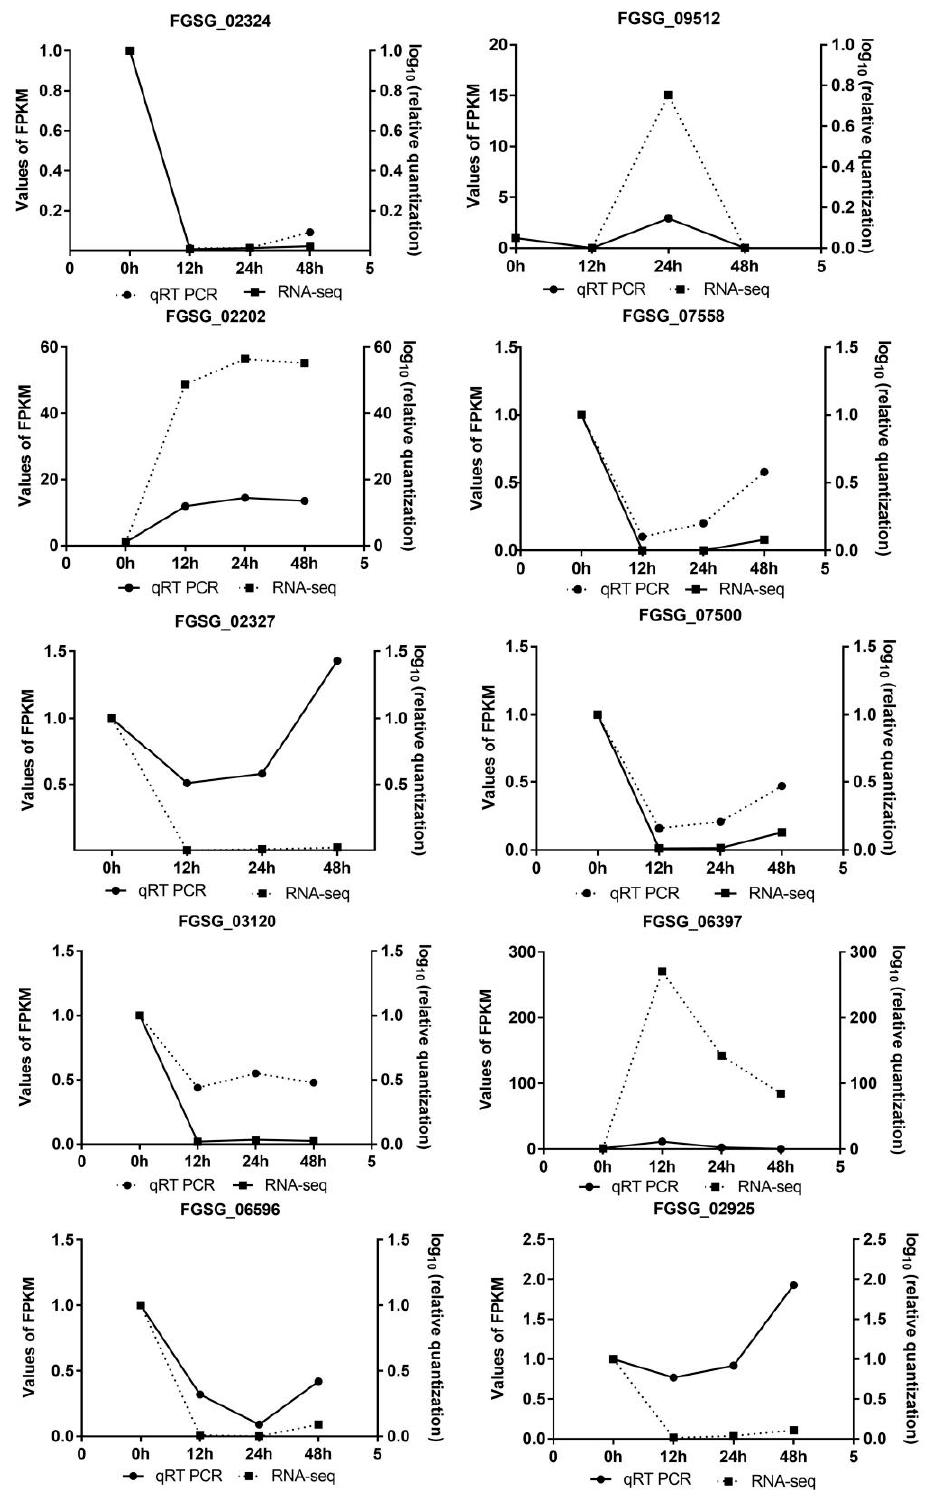
Figure 5. Expression change of 10 randomly selected genes of F. graminearum from RNA-seq. The expression pattern and level of selected genes from RNA-seq results were compared with those quantified by qRT-PCR. Quantitative analysis was conducted according to the normalization by the 2 − ∆∆ Ct method using the housekeeping gene EF1- α of the Fusarium genus.